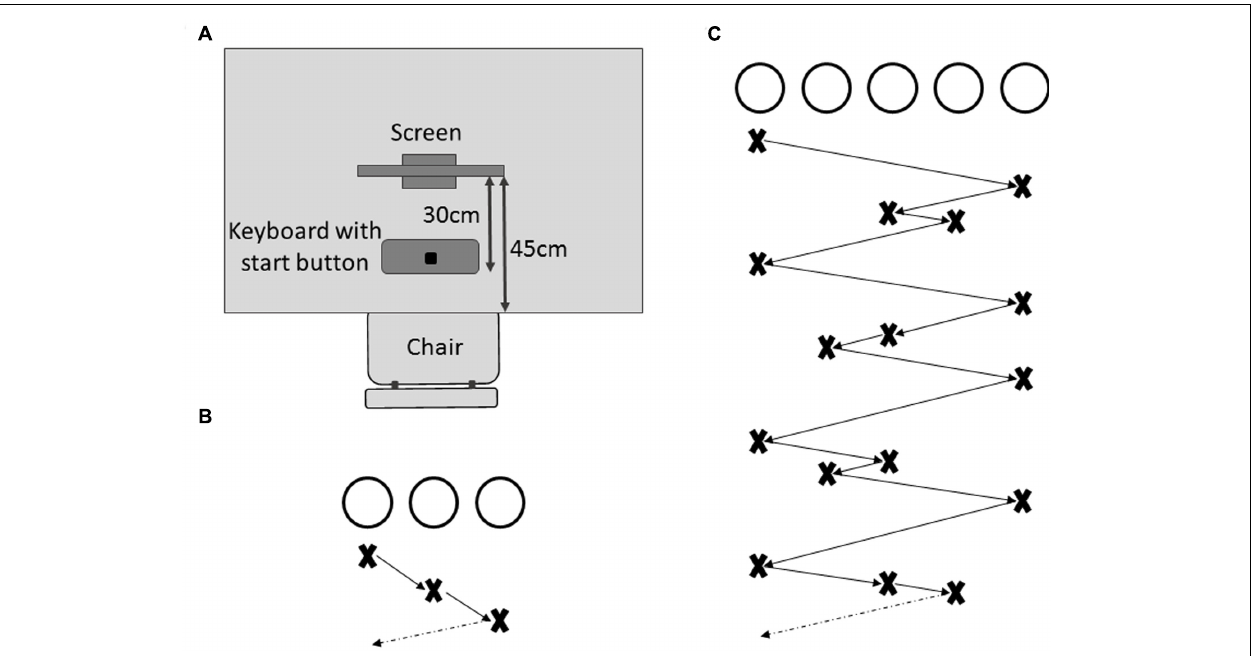
FIGURE 1 | Experimental set-up. (A) Participants were seated on a chair in front of a table on which a touch screen was placed within reaching distance. In between the participant and the touch screen was a keyboard with the start button clearly marked. (B) Display of the practice sequence composed of three black, unfilled circles that illuminated in the order described by the crosses below the circles. (C) Display of the complex sequence to be learned in the complex sequence learning task (CSLT) with crosses and arrows describing the sequence